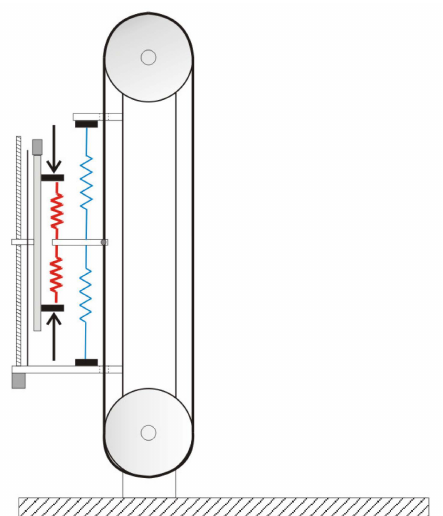
Figure 10. The active mode of BIASAT mechanism. The stoppers are moved toward the high stiffness spring using DC Motor